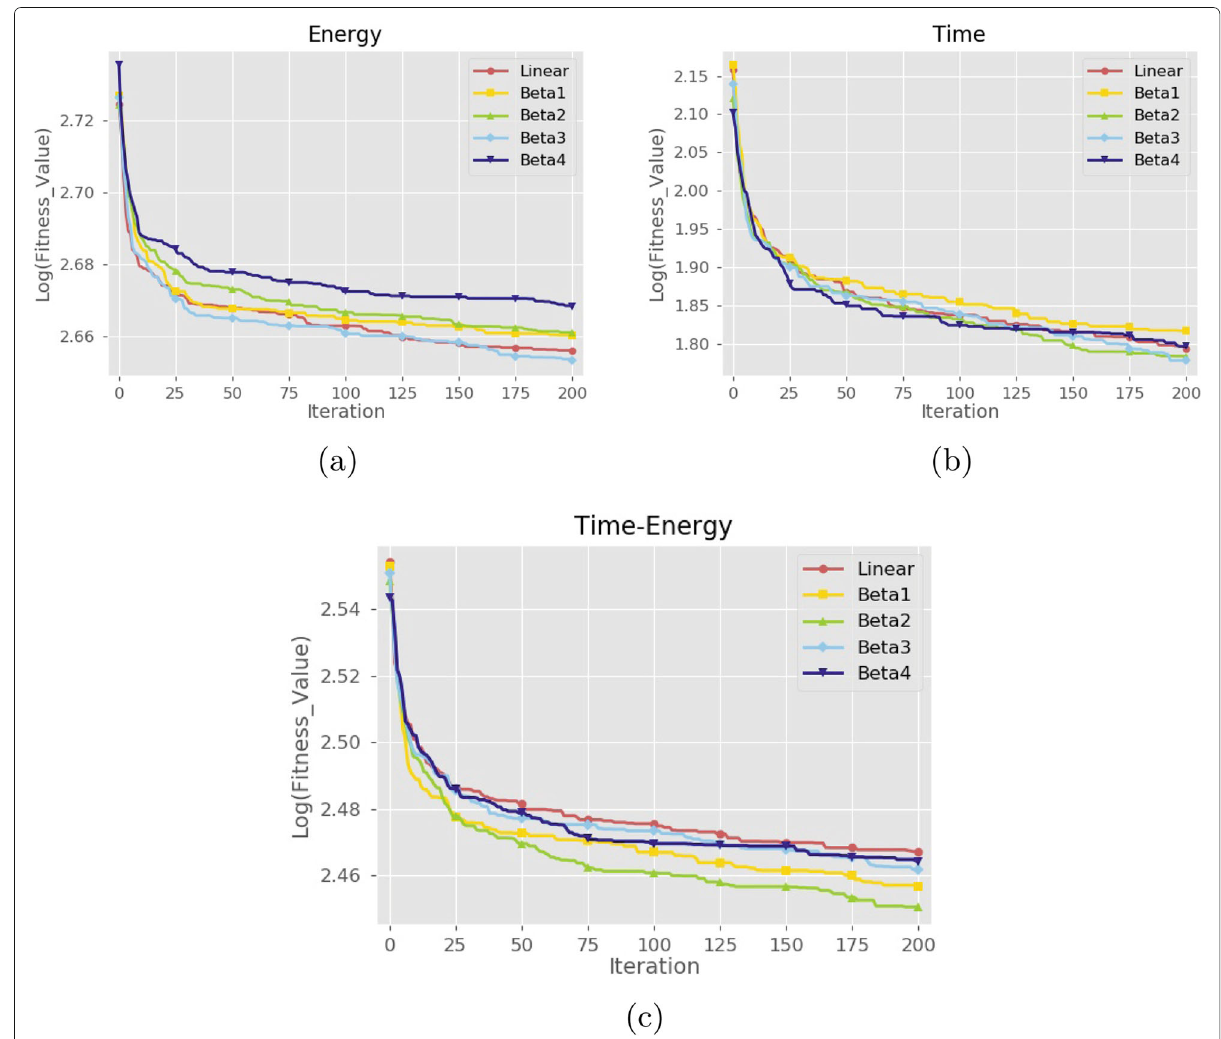
Fig. 11 Performance comparison of 4 non-linear functions with three evaluation metrics